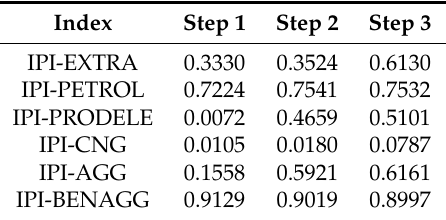
Table 32. Comparison of the ratio between RMSEs with an expanding window for electricity from 2015:01 to 2018:12.